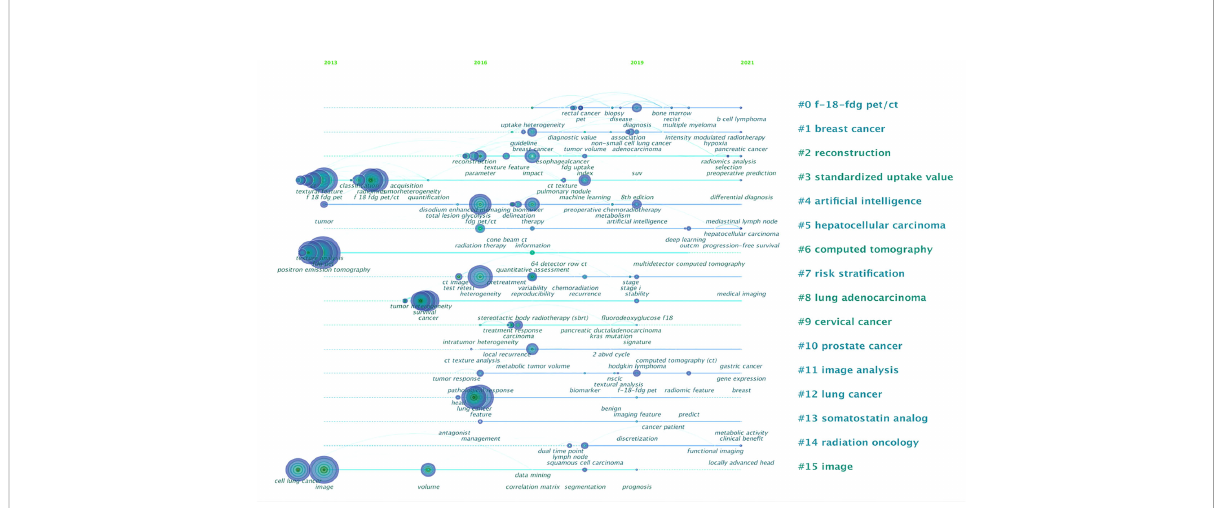
FIGURE 7 Analysis of all keywords in studies related to 18 F-FDG PET/CT radiomics research. In the timeline view of keyword cluster analysis, there are N = 298 and E =